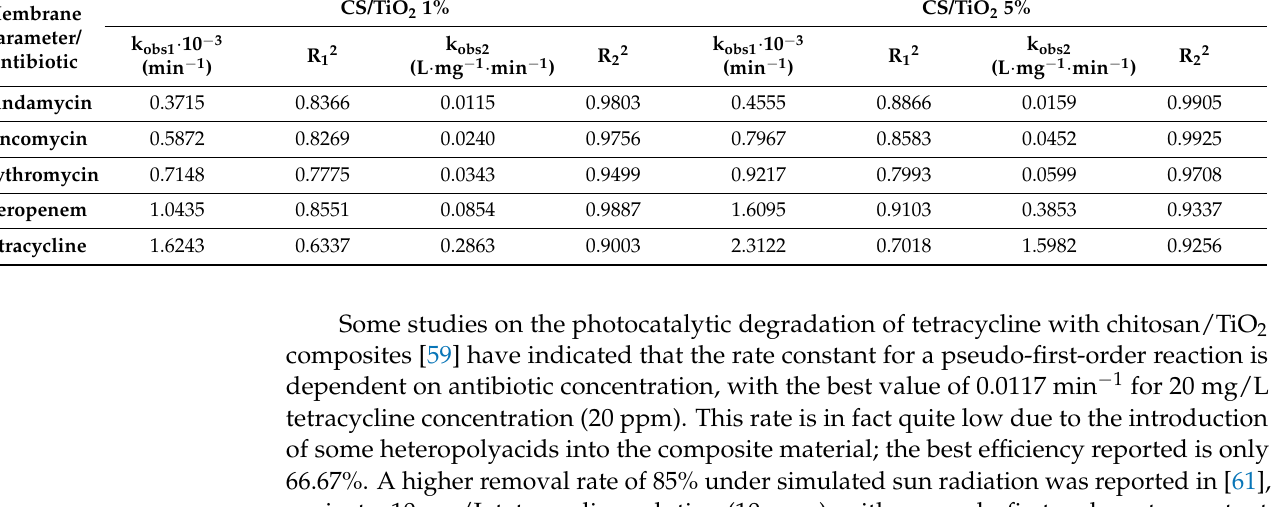
2 1% and ( b ) CS/TiO 2